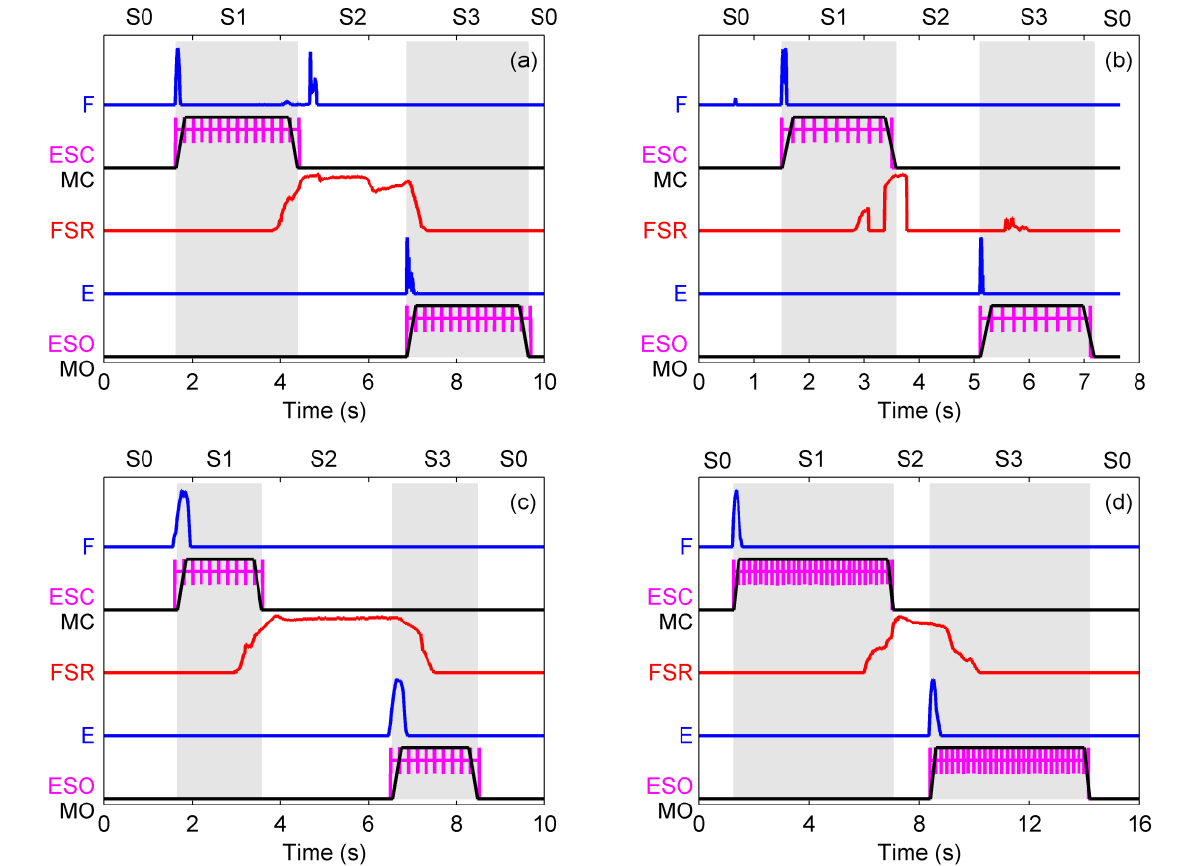
Figure 9. Grasping objects with a hybrid approach: ( a ) glue stick, ( b ) adhesive tape roll, ( c ) bottle, and ( d ) toy. F: FMG flexion stimulus; ESC, MC: FES and motor commands to close the hand; FSR: grip contact force; E: FMG extension stimulus; ESO, MO: FES and motor commands to open the hand. The measured signals are normalized and scaled for the sake of visualization. The gray rectangles indicate the system states.